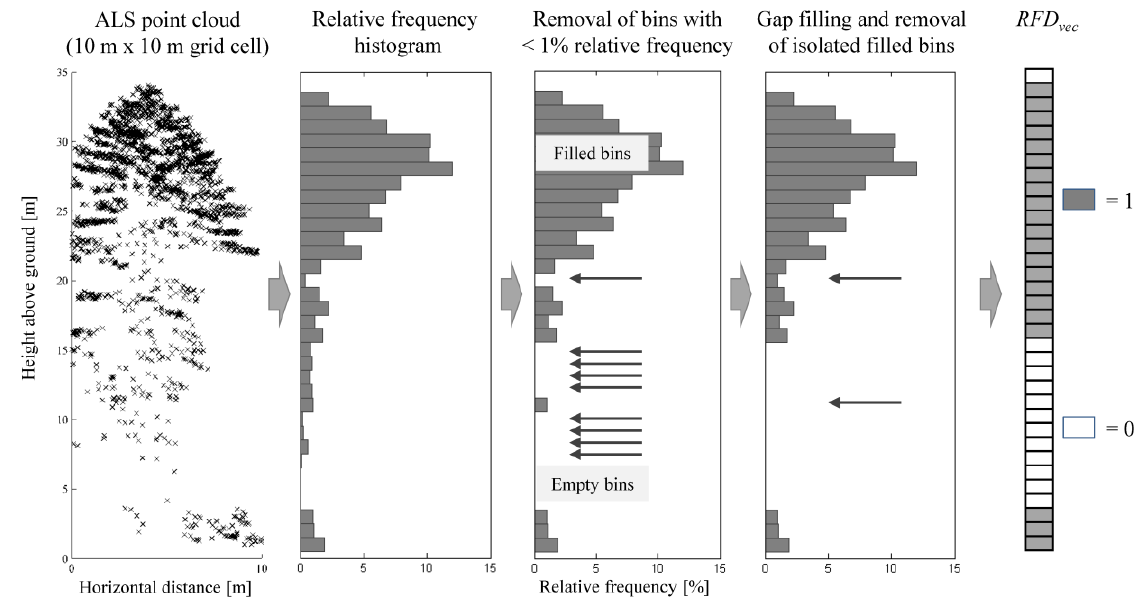
Figure 3. Processing steps from the ALS point cloud to the filtered RFD vec for a selected 10 m × 10